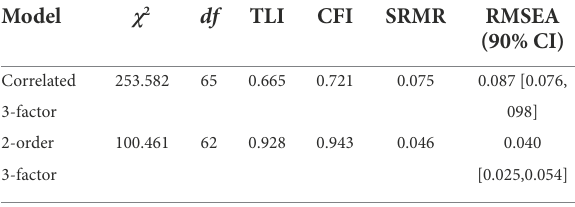
TABLE 3 SCLS of Fit of CFAs for Sample 2 ( n =